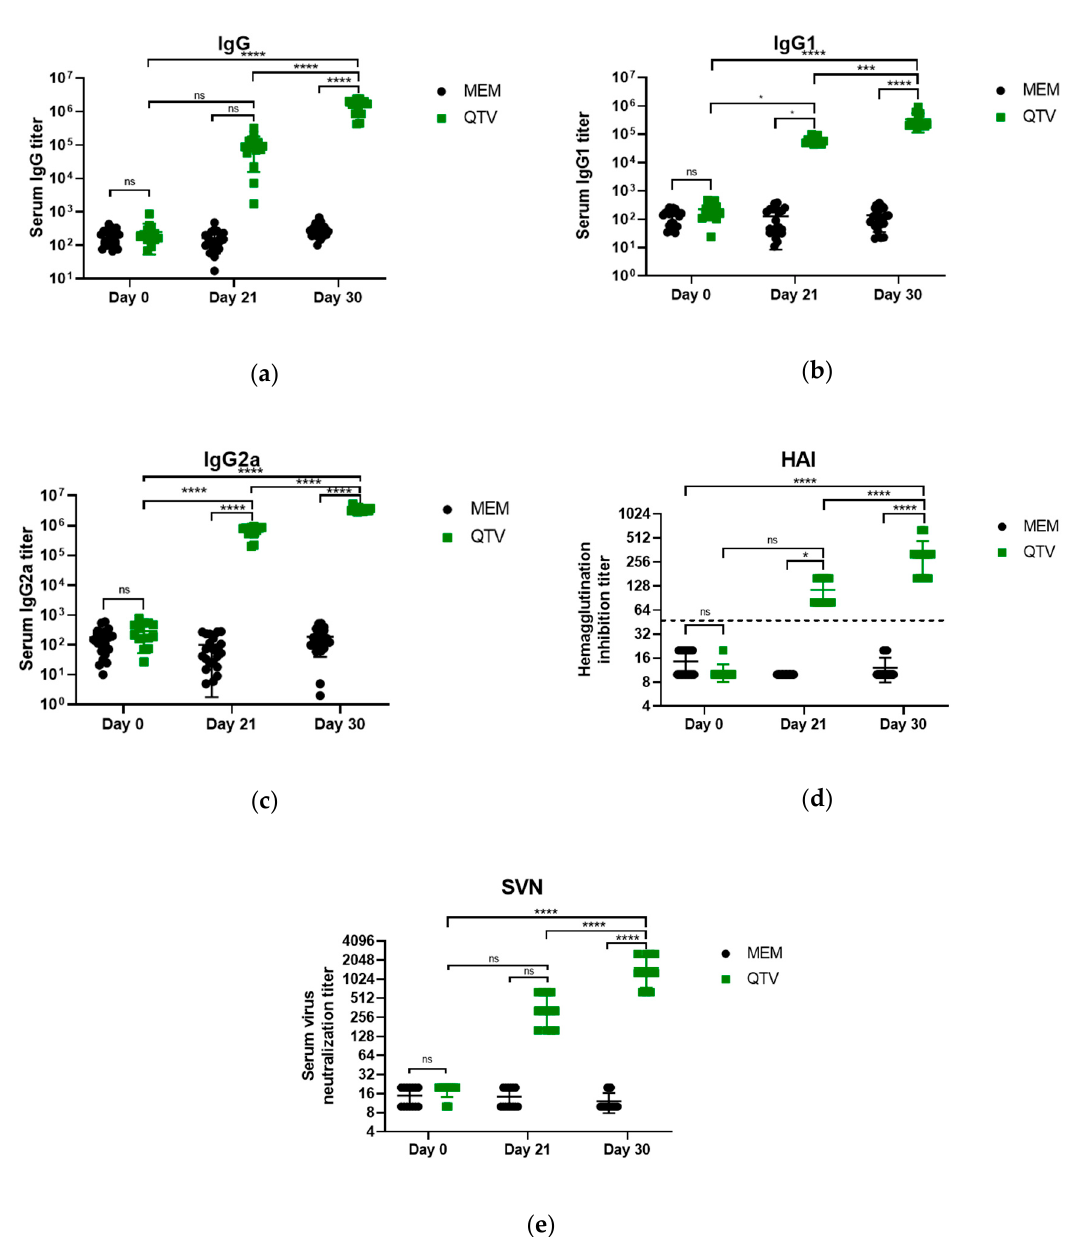
Figure 5. Antibody responses mounted after QTV vaccination. BALB/c mice were vaccinated on days 0 and 21 with MEM (control) or the QTV virus at a dose of 1 × 10 3 PFU. Serum was collected on days 0, 21, and 30 to be titered using an ELISA to detect influenza-specific IgG, IgG1, and IgG2a. Samples were analyzed in triplicate. Serum was also titered for neutralizing antibodies by the HAI assay and SVN assay. ( a ) IgG. ( b ) IgG1. ( c ) IgG2a. ( d ) Serum HAI titres were determined using 0.5% red blood cells (RBCs) against the BC15 (H7N9) (WT) virus. The samples were analyzed in duplicate. The dotted line corresponds to the negative cut-off of 40, which is associated with a 50% reduction in the chance of contracting the influenza virus. ( e ) SVN titres were determined using 100 TCID 50 /50 µl of the BC15 (H7N9) influenza virus. The samples were analyzed in quadruplicate. The data is shown as the mean ± the standard deviation. The dots correspond to the values obtained from individual mouse samples. Significant differences among groups are signified by * ( P < 0.05), ** ( P < 0.01), *** ( P < 0.001) or **** ( P < 0.0001). ns. = not significant. A one-way ANOVA was performed, which was followed by the Tukey post-hoc test to determine the P -value.